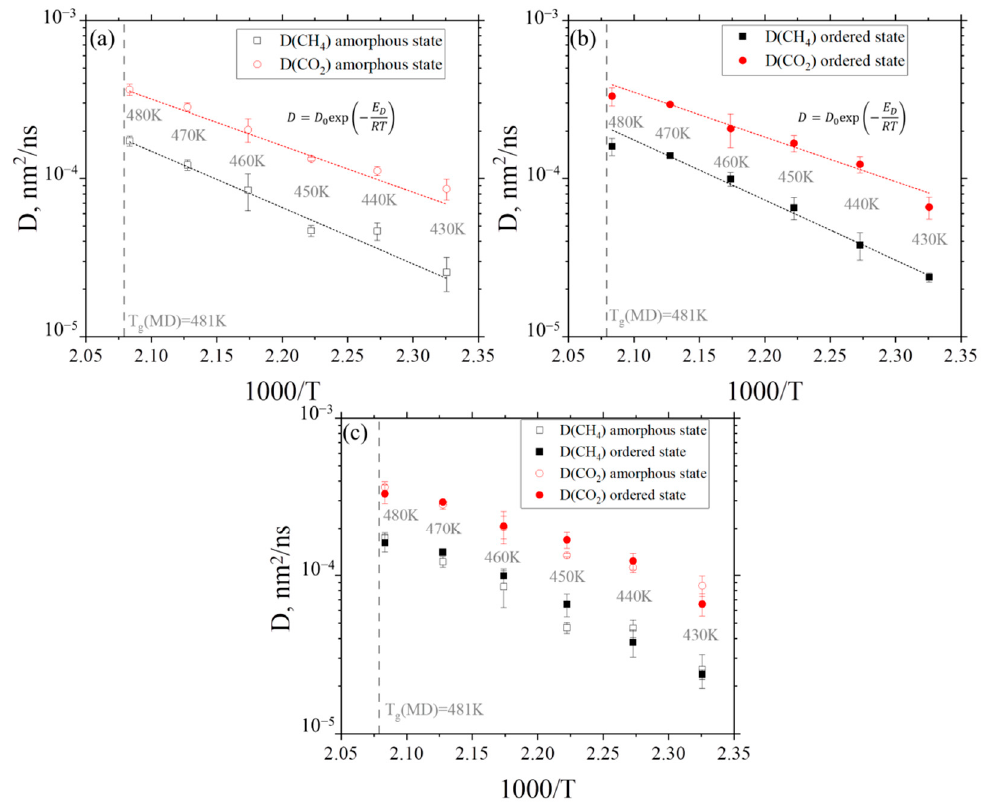
Figure 7. Dependence of the diffusion coefficients of the CH 4 and CO 2 gases in amorphous ( a ) and ordered ( b ) states in BPDA-P3 on the reciprocal temperature. Dashed fitting lines were obtained by approximation of the diffusion coefficient values using the Arrhenius law (Equation (4)). ( c ) Dependence of the diffusion coefficients on the reciprocal temperature for both gases in amorphous and ordered states. Table 1. Activation energy E a of diffusion of the CH 4 and CO 2 gases for BPDA-P3 in amorphous and ordered states.